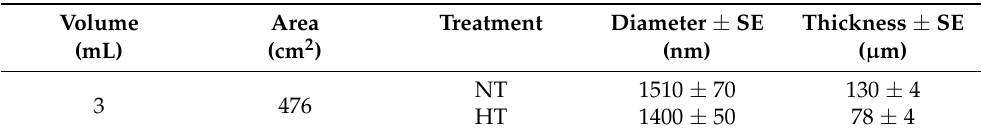
Table 4. Volume of polymer solution used for the synthesis of AEM-NT and AEM-HT, along with the obtained area, fiber diameter and membrane thickness.